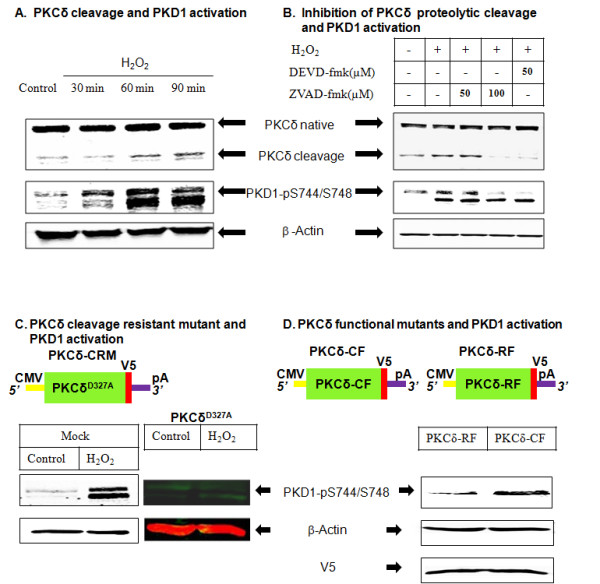
Proteolytically activated PKCδ-CF contributes to PKD1 phosphorylation. N27 dopaminergic cells treated with H2O2 (100 μM) for 30, 60 or 90 minutes were monitored for PKCδ-CF (A). N27 dopaminergic cells were treated with H2O2 ± DEVD-fmk (50 μM) and ± ZVAD-fmk (50 μM and 100 μM) for 60 min and monitored for PKD1 activation and PKCδ cleavage (B). N27 dopaminergic cells stably expressing the cleavage-resistant mutant of PKCδ (PKCδD327A) were treated with H2O2 and monitored for PKD1 activation (C). PKD1 activation was monitored in N27 dopaminergic cells transfected with the catalytic fragment of PKCδ (PKCδ-CF) and the regulatory fragment of PKCδ (PKCδ-RF). Additionally, the mock transfection group treated with or without H2O2 was also monitored for PKD1 activation (D).